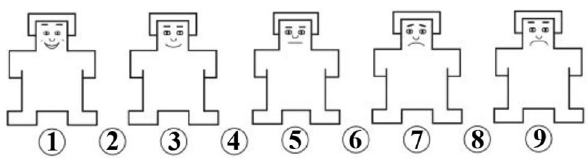
Figure 7. The Self Assessment Manikin. Scale for Valence